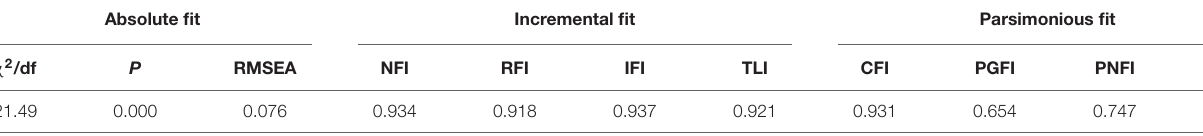
TABLE 4 | Model fit calculation results.